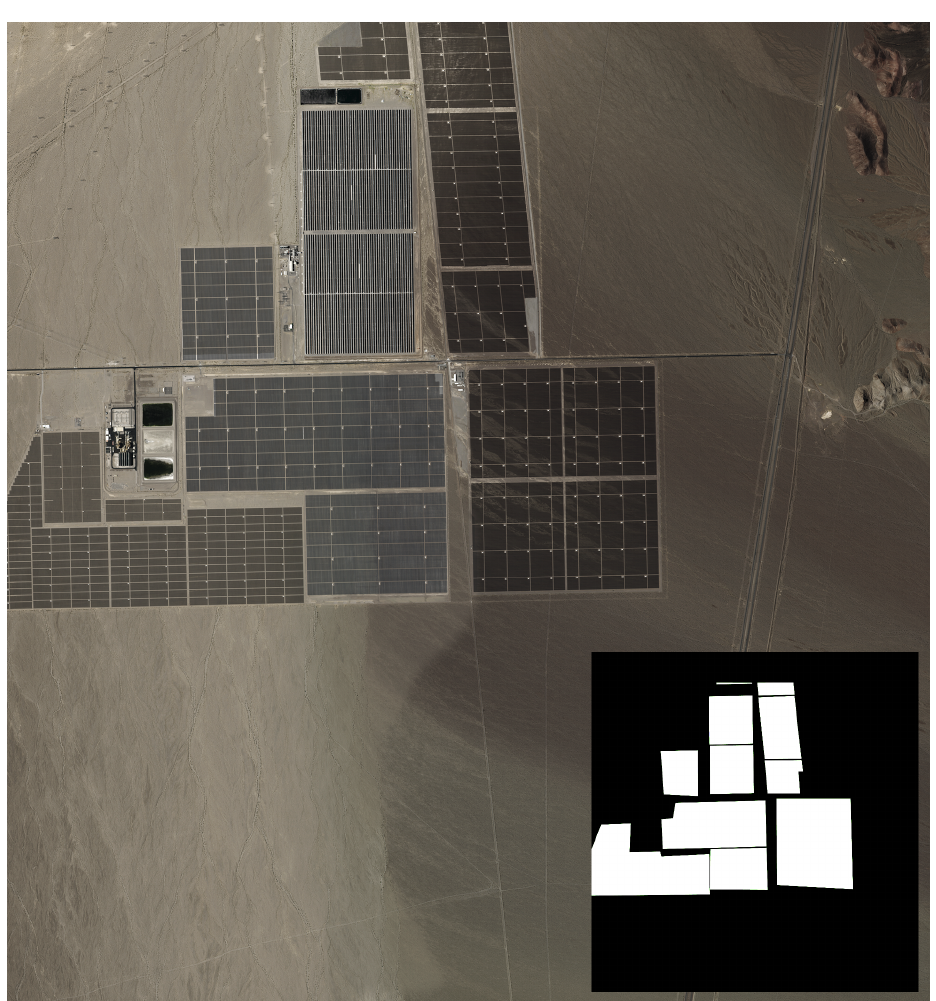
Figure A5. Copper Mountain Solar (35 ◦ 47 (cid:48) N, 114 ◦ 59 (cid:48) W) , along with its corresponding